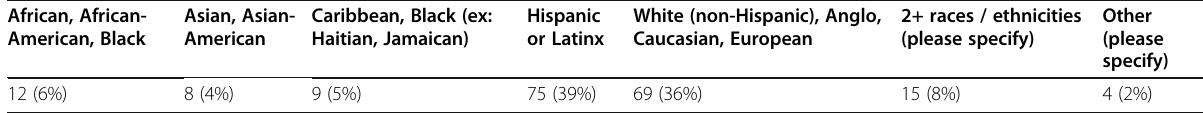
Table 1 Racial and ethnic data for 192 participants who self-identified (of 199 total participants) African, African- Asian, Asian- Caribbean, Black (ex: American, Black American Haitian, Jamaican)